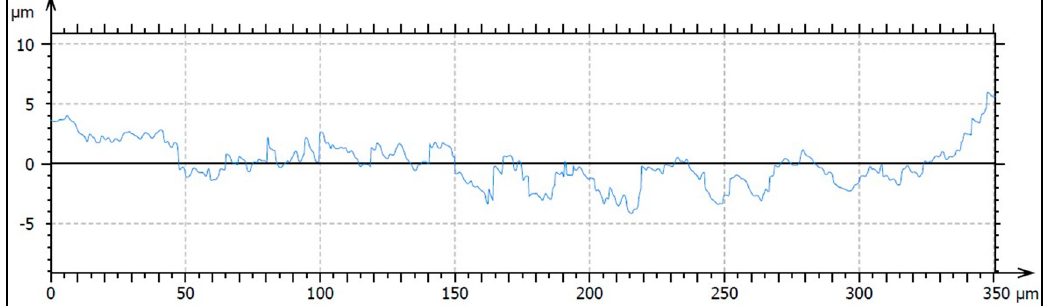
Figure 12. SLA surface profilometry.